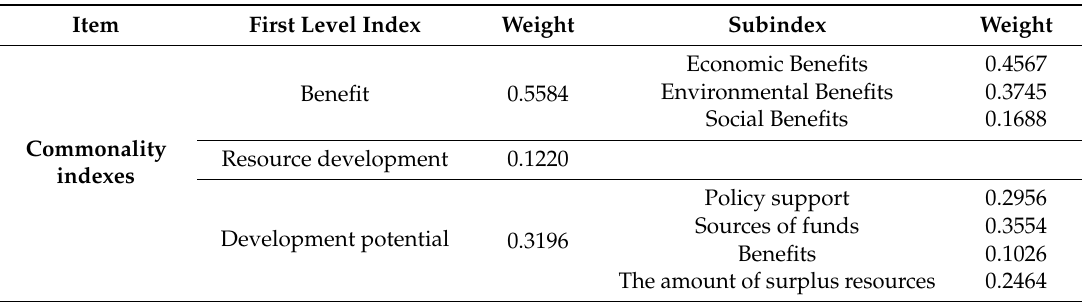
Table 10. Weight of commonality